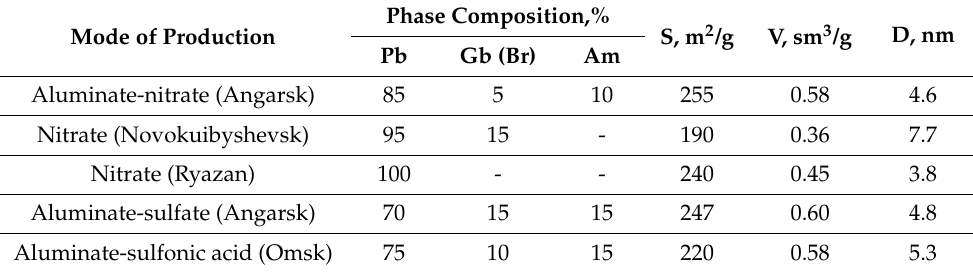
Table 3. Phase composition of industrial aluminum hydroxides and the obtained textural charac- teristics of aluminum oxides [5,15,22,30], where Pb—pseudoboehmite, Gb—gibbsite, Br—bayerite, pore